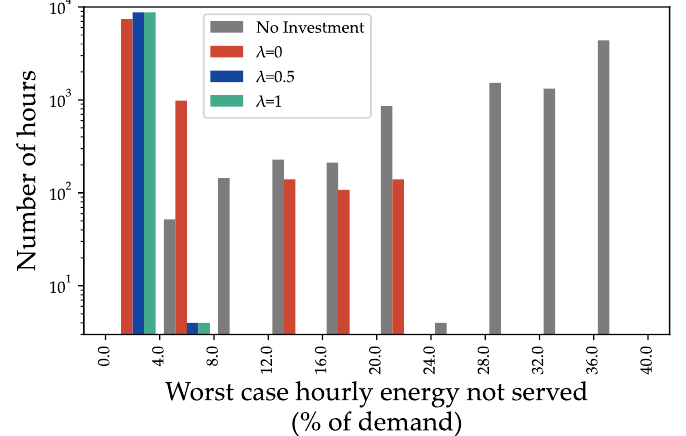
Figure 7. Out-of-sample analysis—Worst case of annual energy not